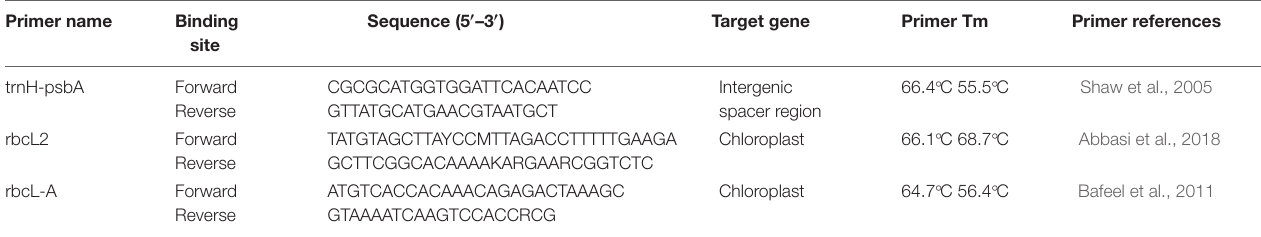
TABLE 1 | The primers used in gene amplification.